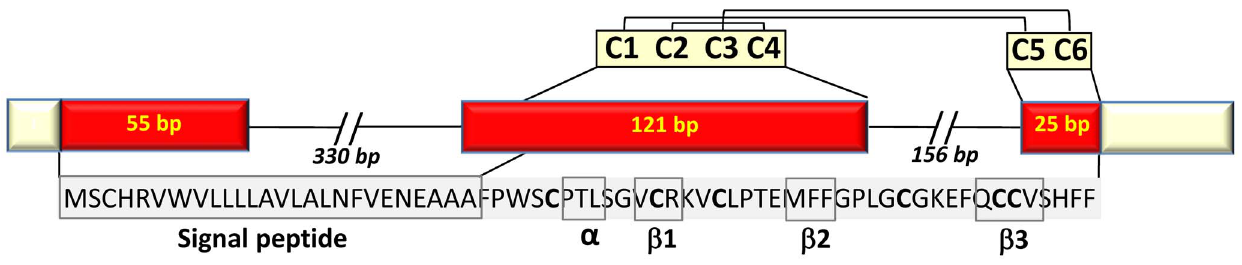
Figure 1. Schematic representation of the beta-defensin gene in Atlantic cod. Pale yellow boxes represent partial 5 9 and 3 9 untranslated regions. Red boxes indicate the coding region corresponding to the 66 amino acid residue peptide precursor. The predicted signal peptide and important secondary structure elements in the mature peptide are boxed. Conserved cysteine residues are highlighted in bold letters and predicted disulphide linkage patterns are also shown.